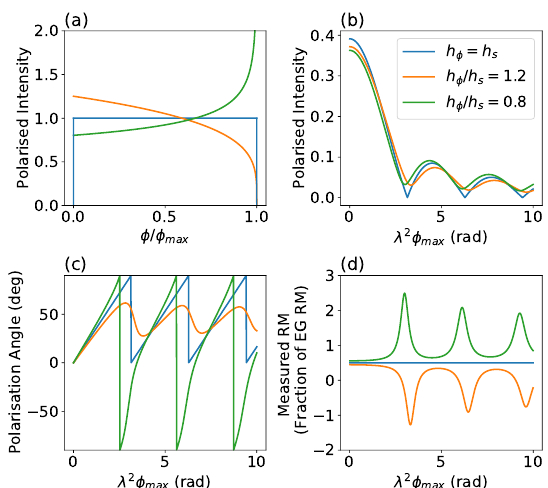
Figure 7. An example of a polarisation model, comparing the ‘slab-like’ case (blue) where h φ and h s are equal ( h φ / h s = 1), to the case with h φ / h s = 1.2 (orange) and the case with h φ / h s = 0.8 (green). ( a ): the Faraday depth spectrum. ( b ): polarised intensity as a function of wavelength squared. ( c ): polarisation angle as a function of wavelength squared. ( d ): the slope of polarisation versus wavelength squared. Please note that in panels ( a ) and ( b ) the units of polarised intensity are arbitrary and the curves have been normalized to have the same integrated